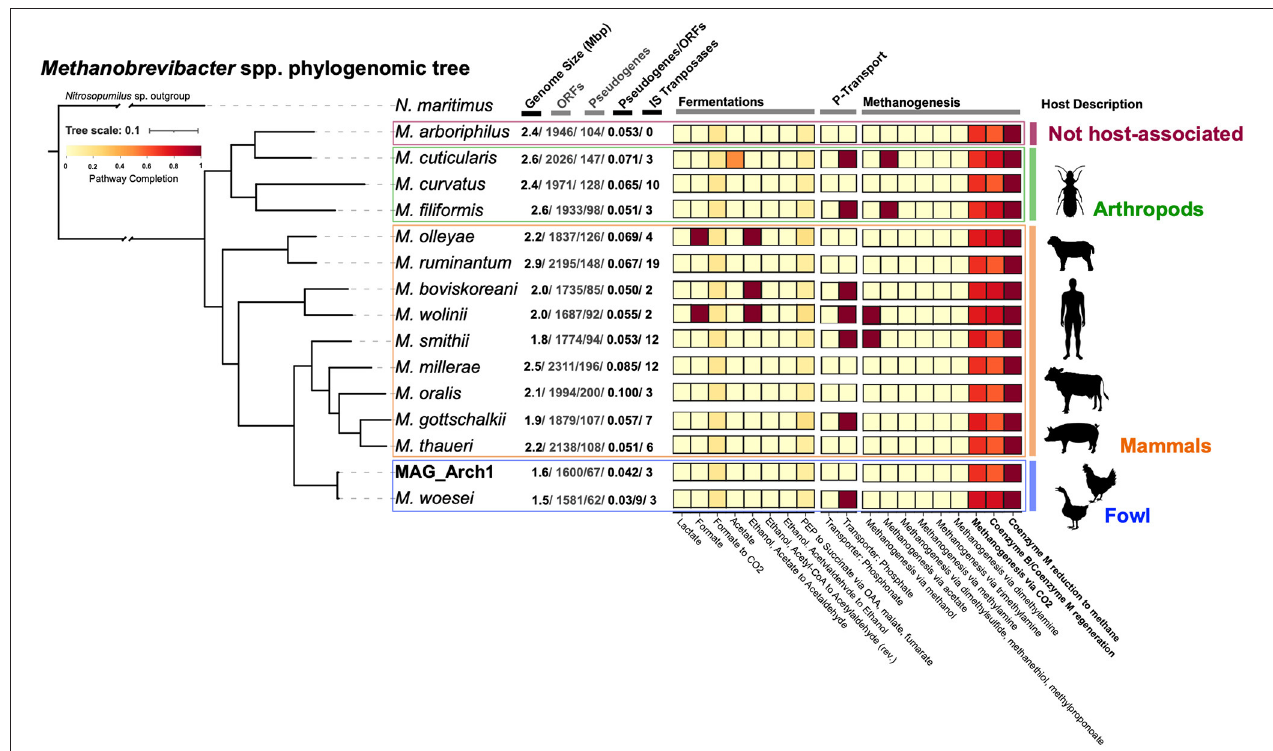
FIGURE 6 | Phylogenomic tree depicting the closest phylogenetic relatives of MAG Arch1. Side panel depicts percent completion prediction for various metabolism modules associated with fermentative and methanogenic activity. The schematics to the right depict the animal host source of each genome in the